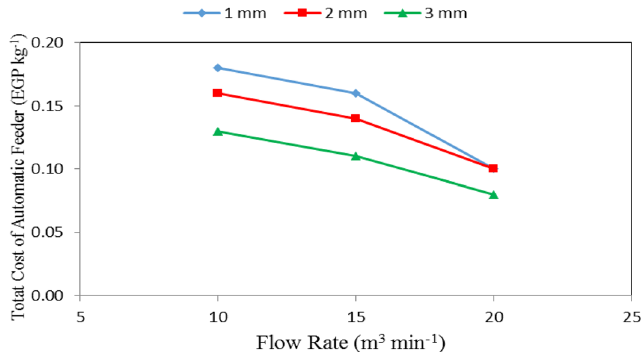
Figure 14. Total cost of automatic feeder at different feed pellet sizes and air flow